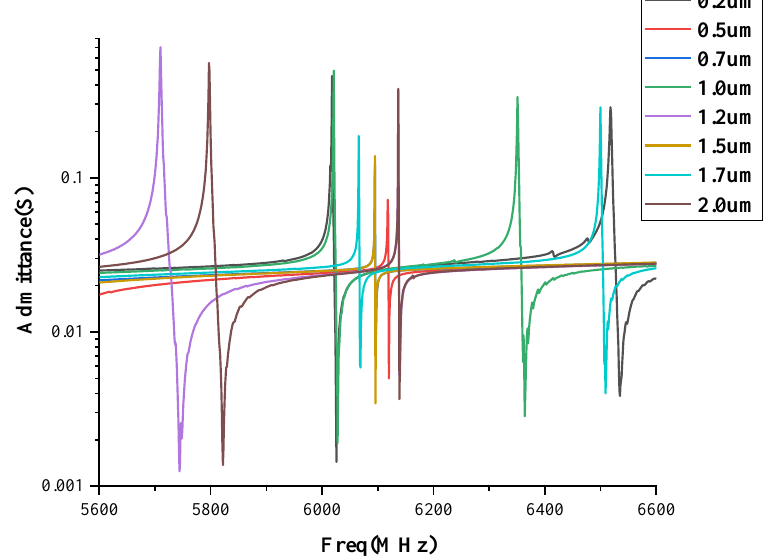
Figure 7. Absolute admittance spectra against the different thicknesses of the Si 3 N 4 support layer.